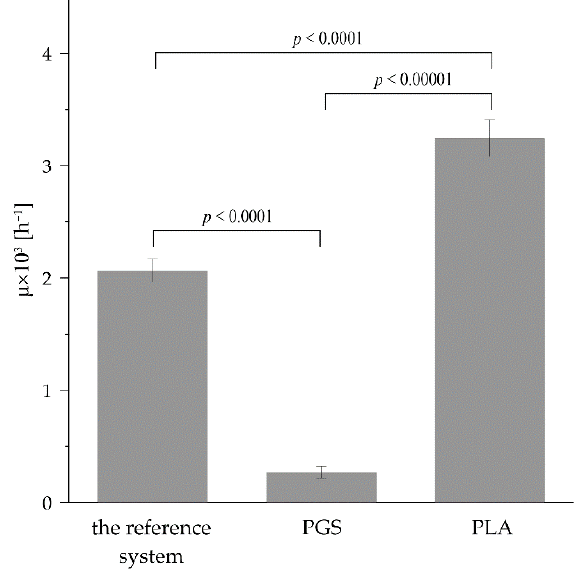
Figure 7. The values of µ characterizing in vitro cultures of R. graeca hairy roots proliferated in the reference system and systems supported with PGS- and PLA-based scaffolds. The p values over brackets were determined according to the ANOVA test.